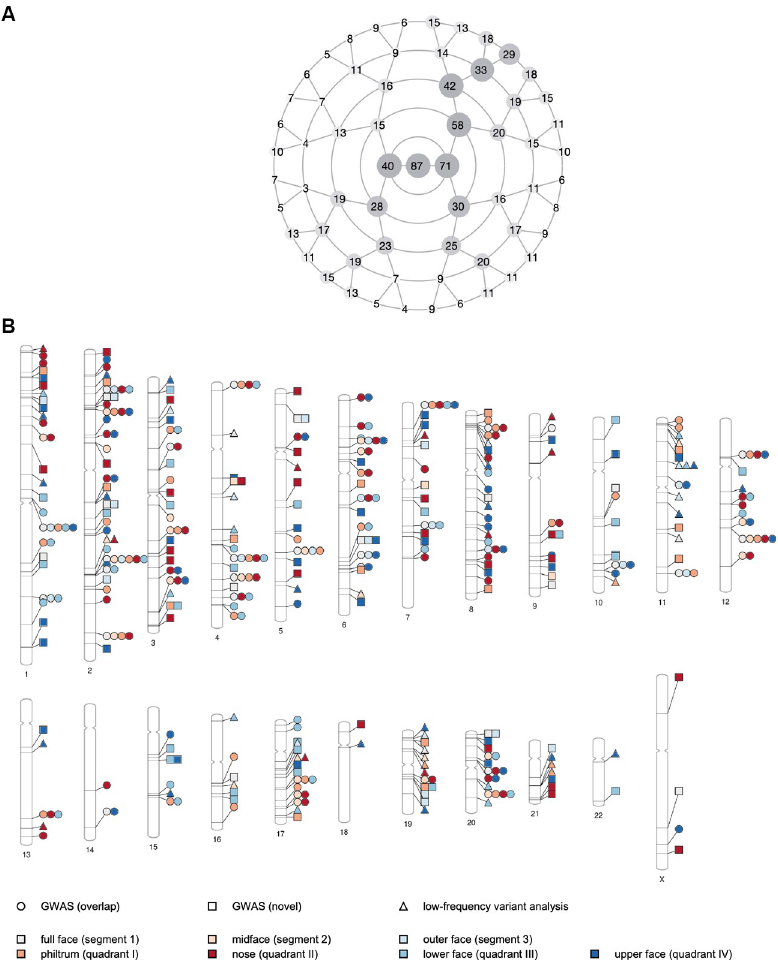
Fig 3. Genetic loci associated with the sib-shared traits. (A) Number of sib-shared traits extracted per facial segment, corresponding to the number of sibling pairs that matched close to perfect within a given segment using the Mahalanobis angle. A total of 1,048 traits were extracted across all 63 segments, comprising 322 independent traits. The structure of the rosette plot corresponds to the polar dendrogram displaying the facial segments in Fig 2A. (B) Ideogram of the genetic loci that contribute to variation in the sib-shared traits, as identified by the association analysis of genome-wide common variants, depicted by circles and squares (i.e. overlapping and novel loci, respectively), and exome-wide low-frequency variants, depicted by triangles. For each locus, the color of the symbol represents the quadrant in which the top associated effect (i.e. lowest p-value) was observed.